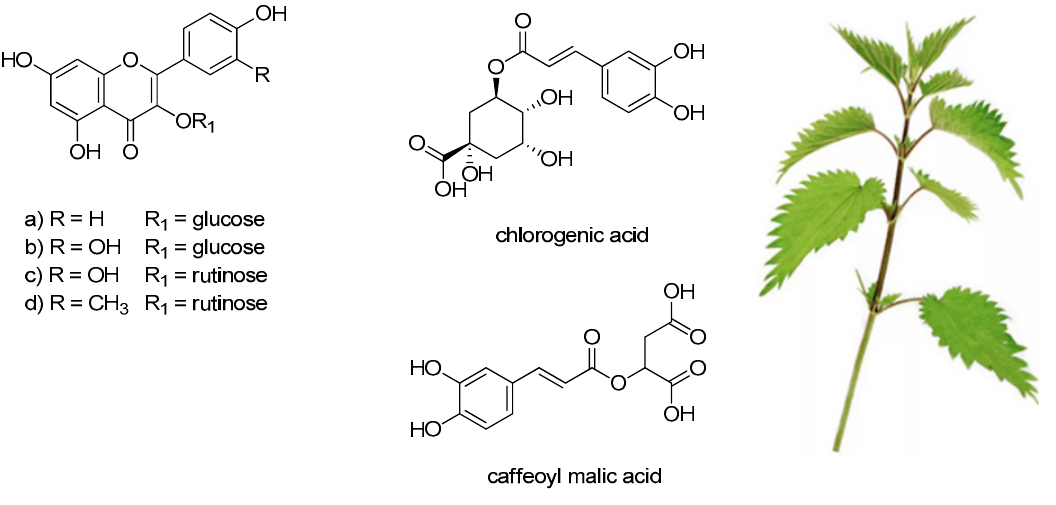
Figure 2. Phenols and polyphenols mostly detected in U. dioica leaves. ( a ) kaempferol-3- O -glucoside; ( b ) quercetin-3- O -glucoside; ( c ) rutin; ( d ) isorhamnetin-3- O -rutinoside. Among lipid secondary metabolites, carotenoids were detected in the leaves and their total content was estimated equal to 29.6 mg/100 g dry weight [4,23].